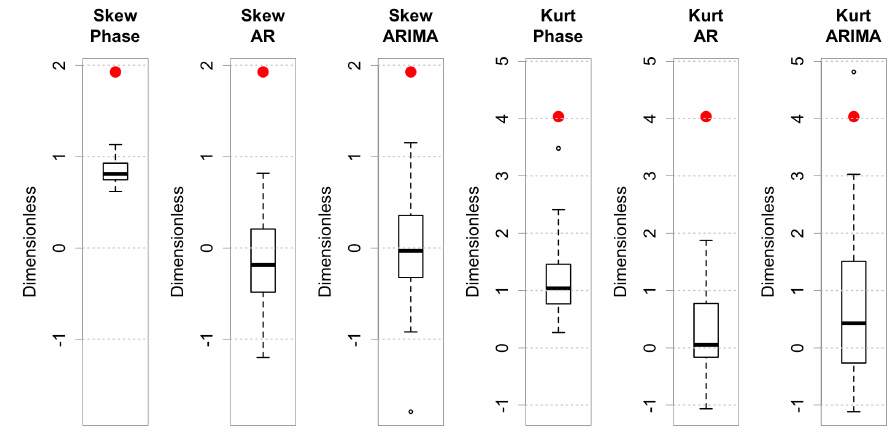
Figure 16. Boxplots of skew and kurtosis comparing the performance of reconstruction methods in simulating the 5 a.m. hourly energy usage by the electric DHW heater in RBSA home 13088, from Q2 2012–Q1 2013 inclusive. Statistics of empirical observations are denoted by red dots. For skew and kurtosis, the phase randomization method had somewhat better